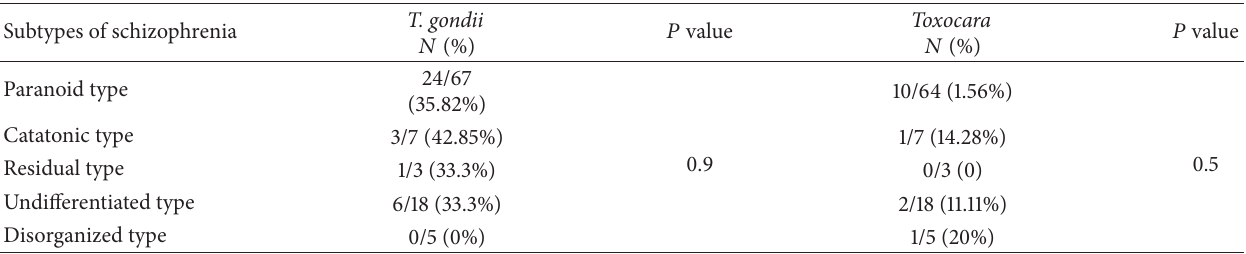
Table 3: The distribution of Toxoplasma gondii and Toxocara antibodies in patients with different subtypes of schizophrenia